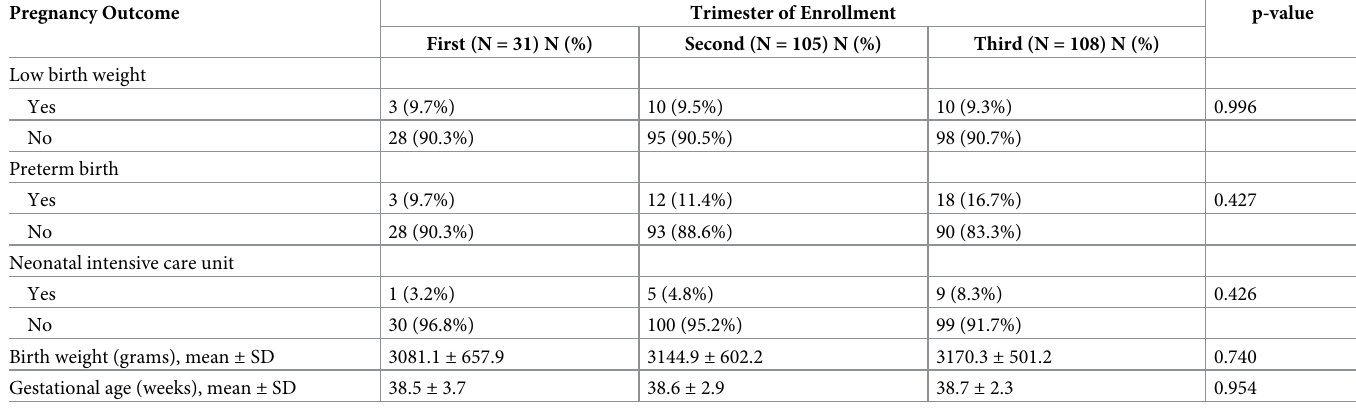
Table 3. Pregnancy outcomes by trimester of enrollment in WIN Network.